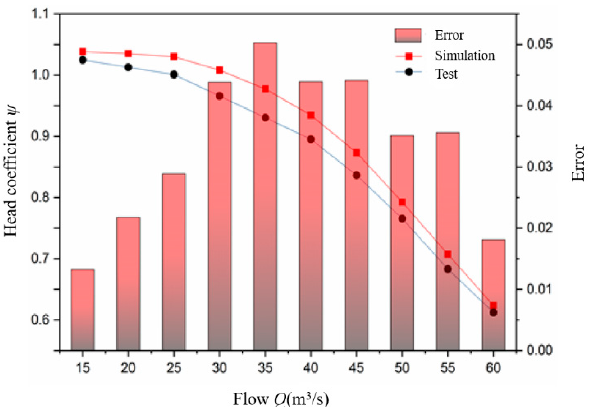
Figure 8. Comparison between test value and simulated value of head coefficient.